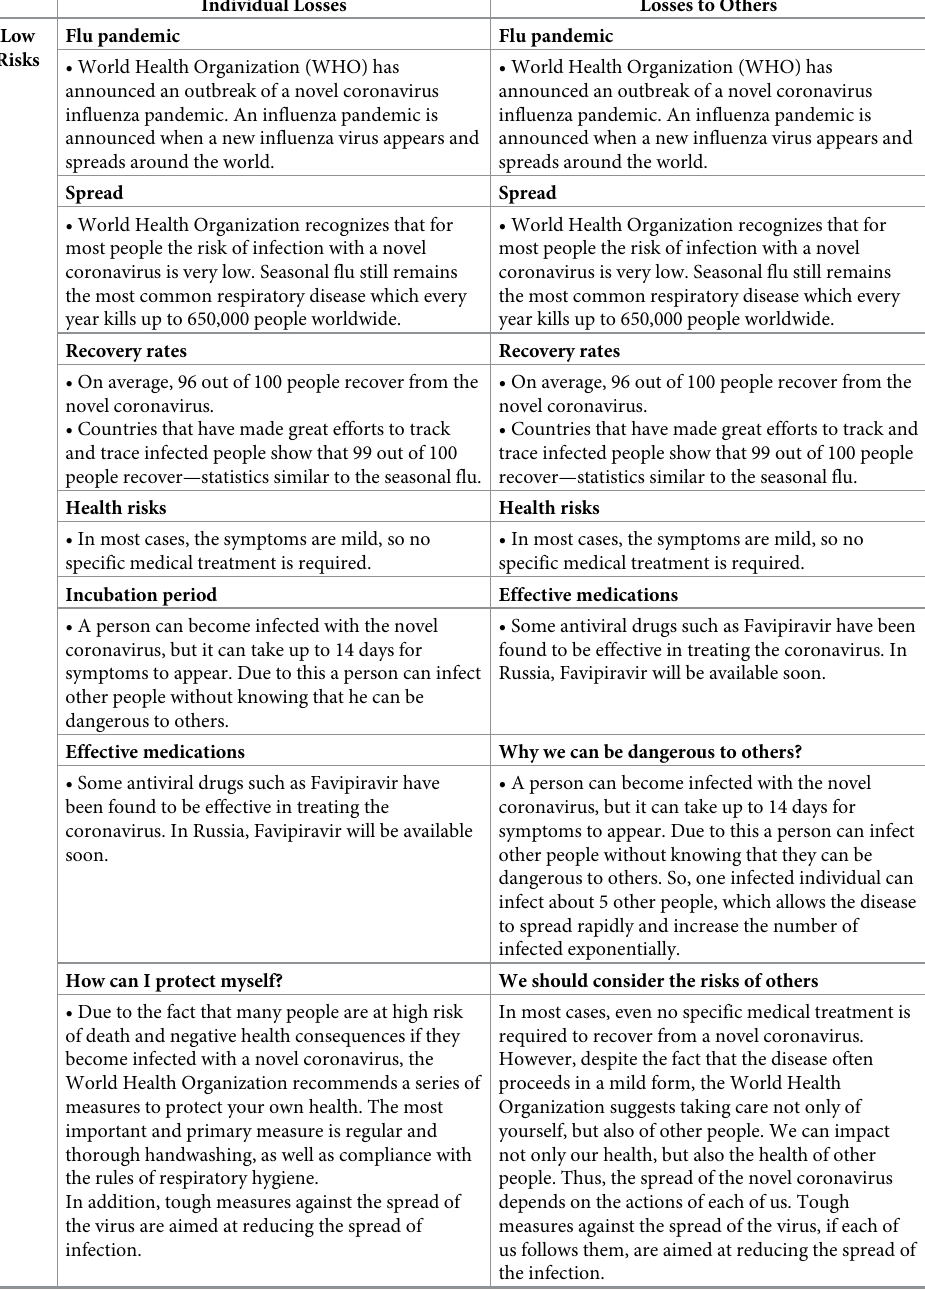
Table 1. Experimental vignettes used in Experiment